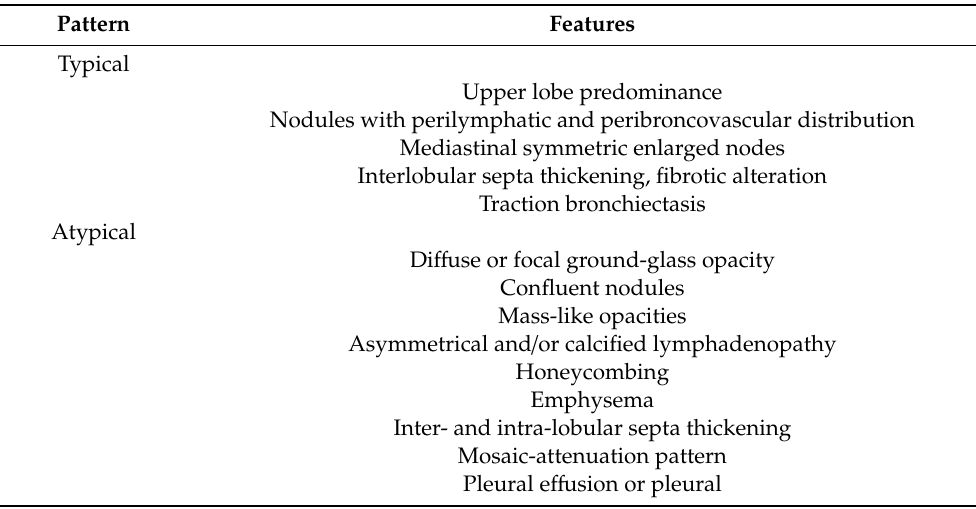
Table 1. Criteria adopted for the definition of typical and atypical patterns.